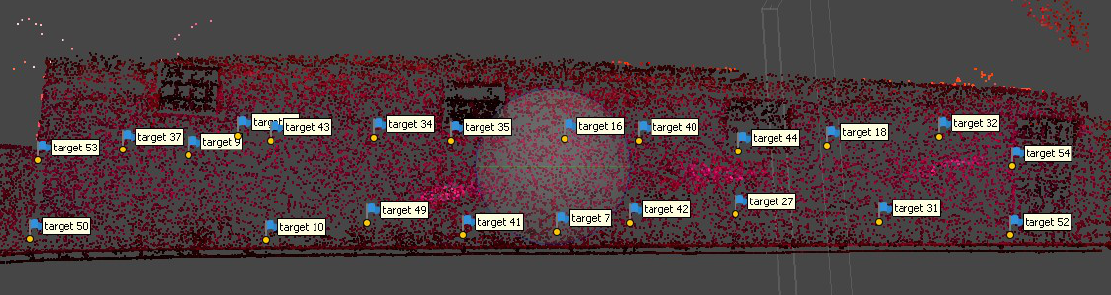
Figure 14. Diagram with the location of all precision targets on the studied historic wall (NIR point